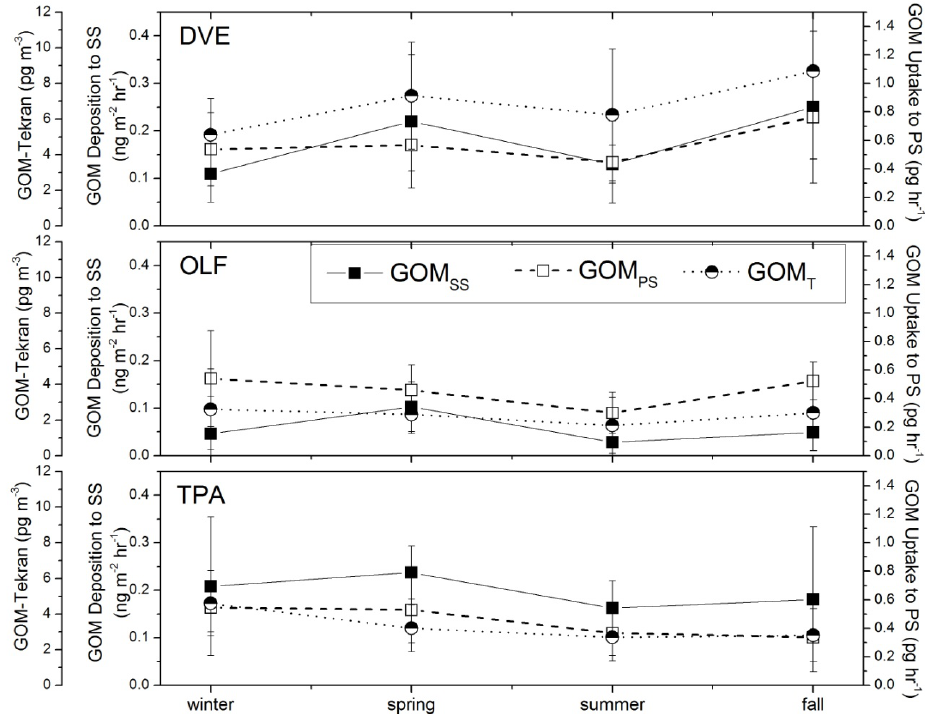
Fig. 4. Seasonal means ± 1 sd of Tekran-GOM air concentration (GOMT), GOM dry deposition to a surrogate surface (GOMSS), and GOM uptake to a passive sampler (GOMPS) measured at DVE, OLF and